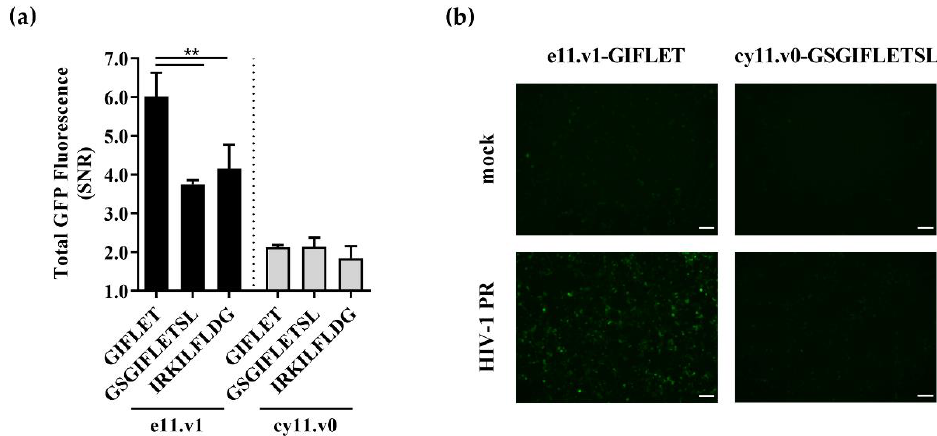
Figure 3. Impact of backbones and cleavable sequences on e11 and cy11 sensors performance for detection of lentiviral proteolytic activity. ( a ) Sensor performance as given by GFP signal-to-noise ratio (SNR) of different cleavable sequences in e11.v1 and cy11.v0 backbones was assessed by flow cytometry 48 h after transient co-transfection. Data shown as mean ± SD of at least three independ- ent experiments. **, p < 0.01 as given by ANOVA followed by Tukey’s post-hoc test. ( b ) Fluores- cence microscopy of e11.v1-GIFLET and cy11.v0-GSGIFLETSL sensors 48 h after co-transfection with GFP10 and a mock plasmid or HIV-1 PR-coding plasmid. Scale bar = 100 µm.